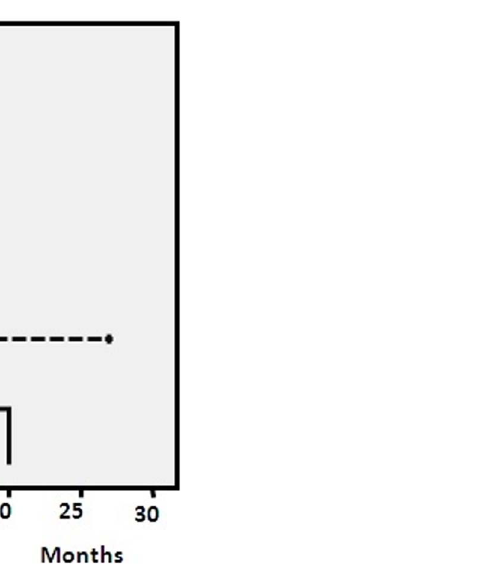
Figure 2. Progression free survival in TMZ/FM treated patients with respect to m/z 6411 and 4075 overexpression. The median value of expression has been considered as cutoff to discriminate peak overexpression. p 5 0.024. — : patients with basal level of the 2 peaks; ---: patients with overexpression of both peaks.